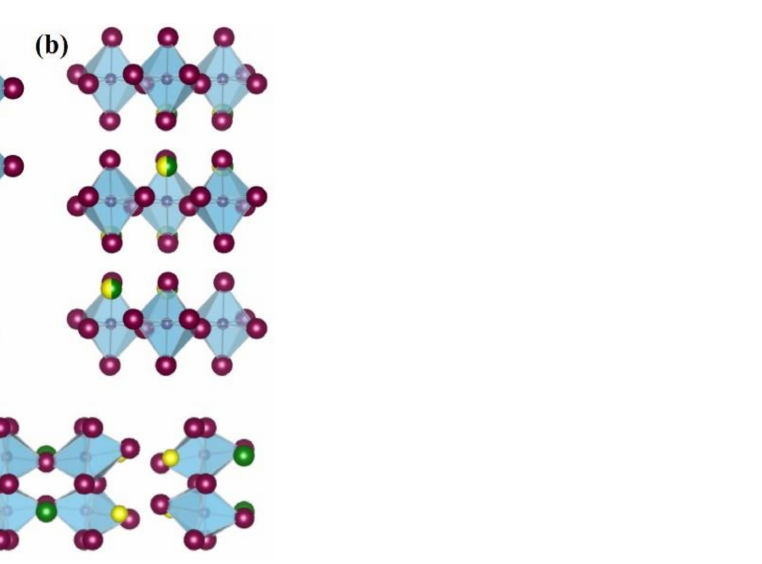
Figure 1. Structure of BaZrO 3 (ABO 3 ) ( a ), BaLaInO 4 (AA (cid:48) BO 4 ) ( b ) and BaLa 2 In 2 O 7 (AA 2 (cid:48) B 2 O 7 ) ( c ), where red spheres represent the oxygen atoms; green spheres represent the atoms of A-sublattice; and yellow spheres represent the atoms of A (cid:48)